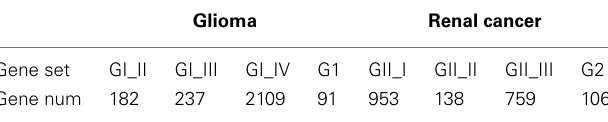
Table 2 |The rank sum test results of glioma and renal